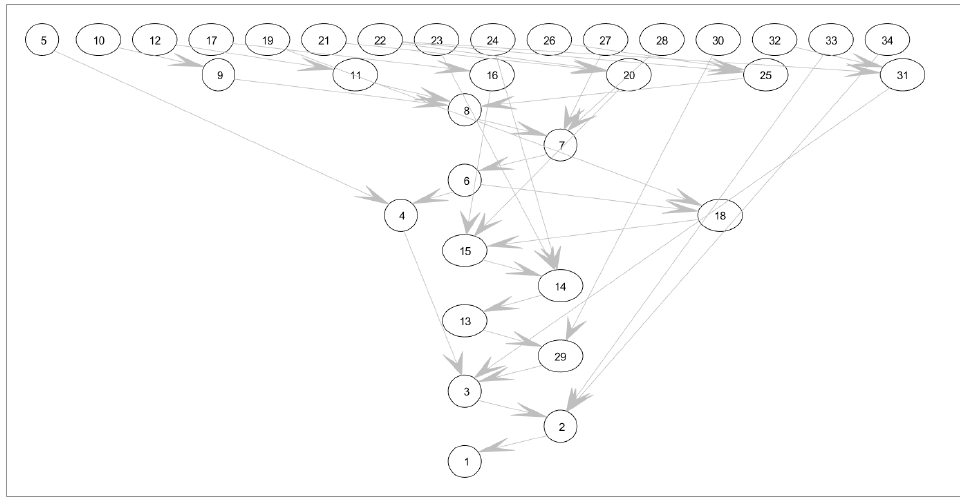
Figure 7. Attack